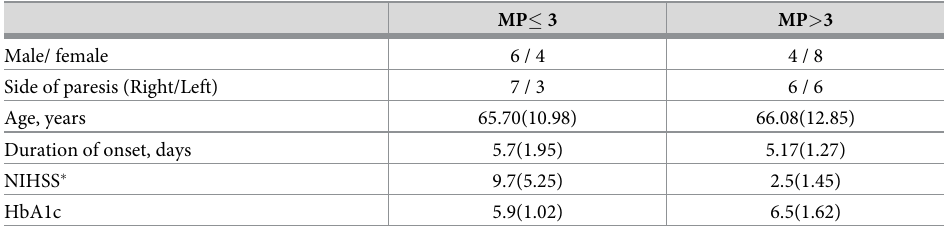
Table 3. Clinical profiles of subgroups by the muscle strength in paretic